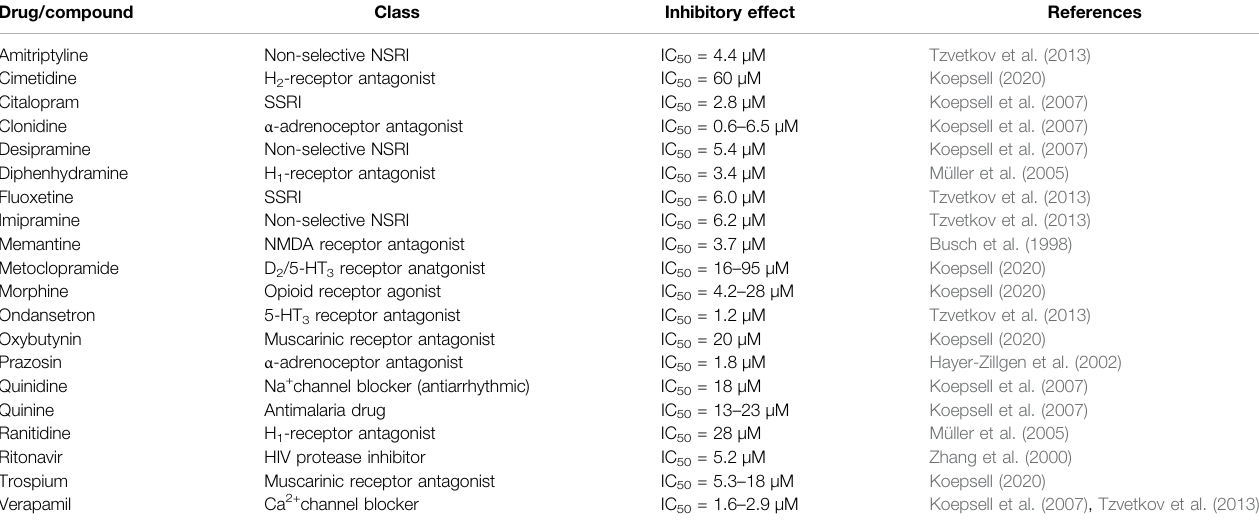
TABLE 3 | Overview of clinically relevant drugs that are orally administered and potent inhibitors of OCT1.